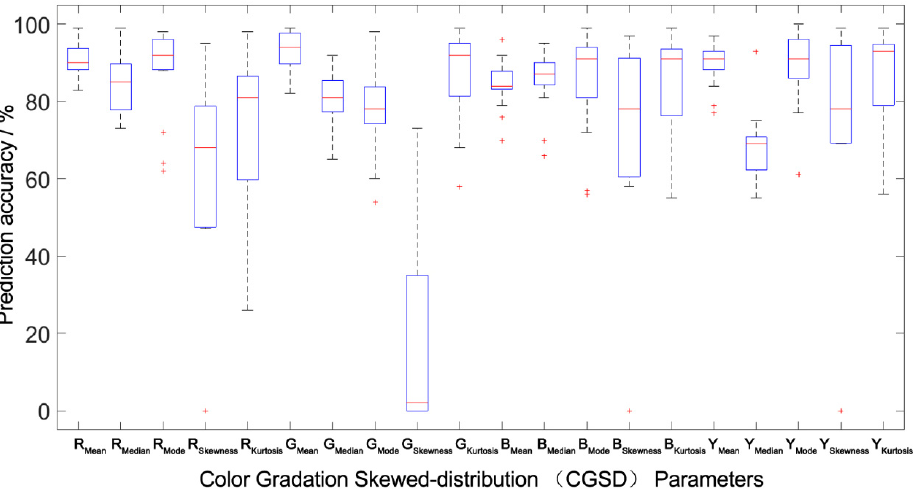
Figure 6. Prediction accuracy interval analysis of the population canopy color-meteorological re- sponse models of the between-group. The Boxplot function of MATLAB was used to draw the accuracy percentile distribution diagram of the population canopy CGSD parameters prediction model. The blue box in the figure represents the prediction accuracy of the model distributed between 25% and 75%. The shorter the box, the better the degree of data concentration. The red line in the box represents the median distribution of prediction accuracy, and the dotted line at both ends outside the box represents the endpoint value (maximum and minimum) of the prediction data distribution. The shorter the distance between the two endpoint values, the better the degree of data concentration. The red cross outside the box represents abnormal data. The fewer abnormal data, the better the degree of data distribution concentration.